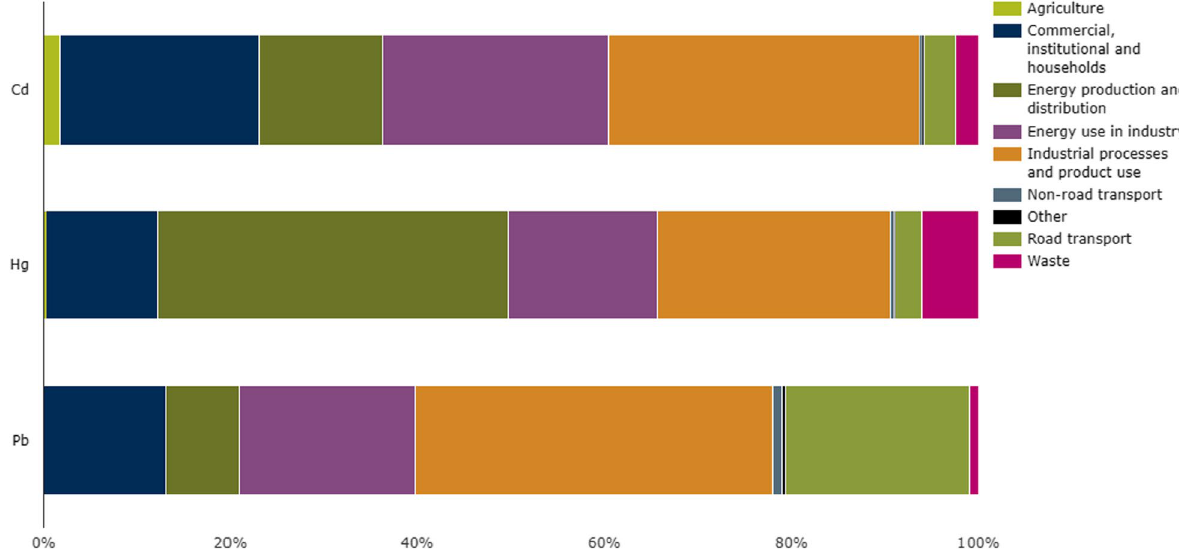
Fig. 1 Effect of different life sectors on the emission of Cd, Hg, and Pb in the environment (EEA,